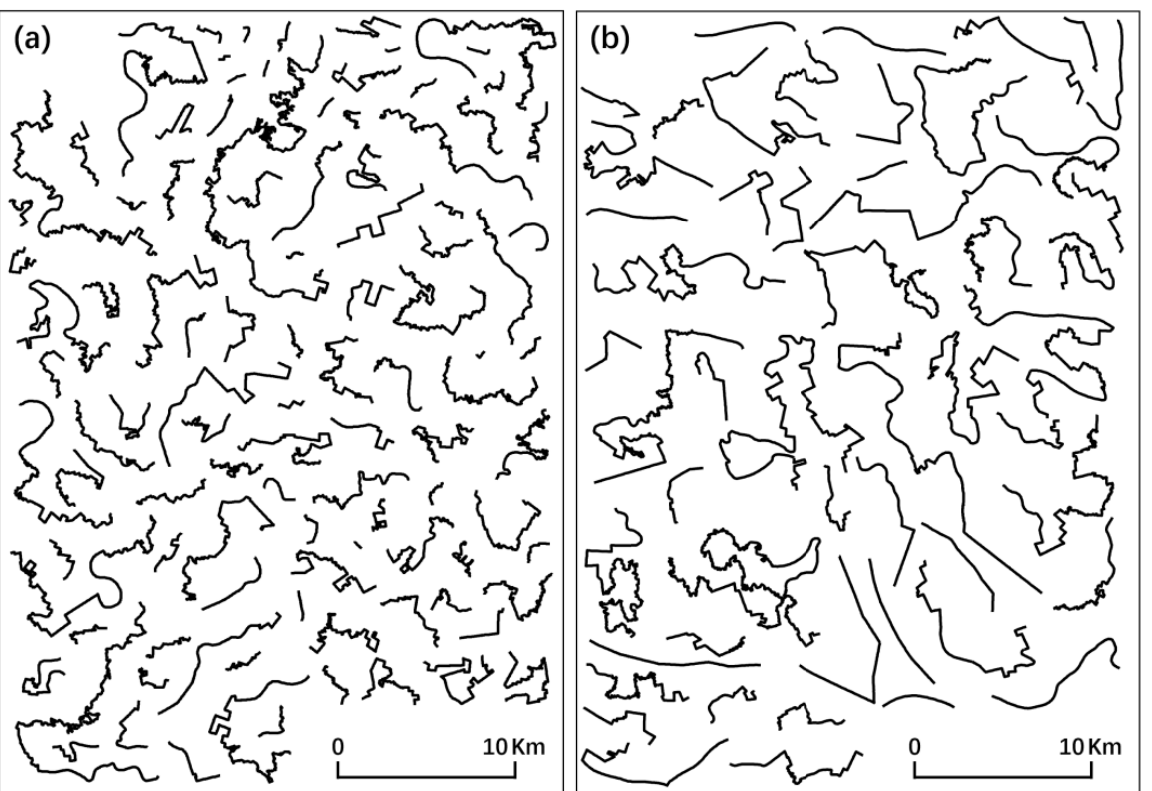
Figure 2. Experimental data: ( a ) administrative boundaries in the training dataset, and ( b ) adminis- trative boundaries in the testing dataset.